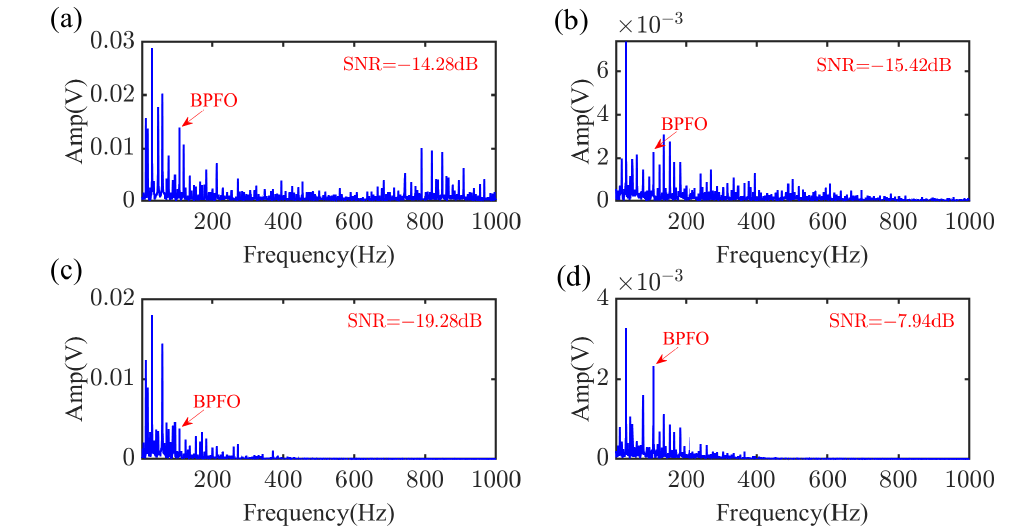
Figure 7. Envelope spectrum analysis results: ( a ) original signal; ( b ) band-pass filter; ( c ) VMD; ( d ) the proposed